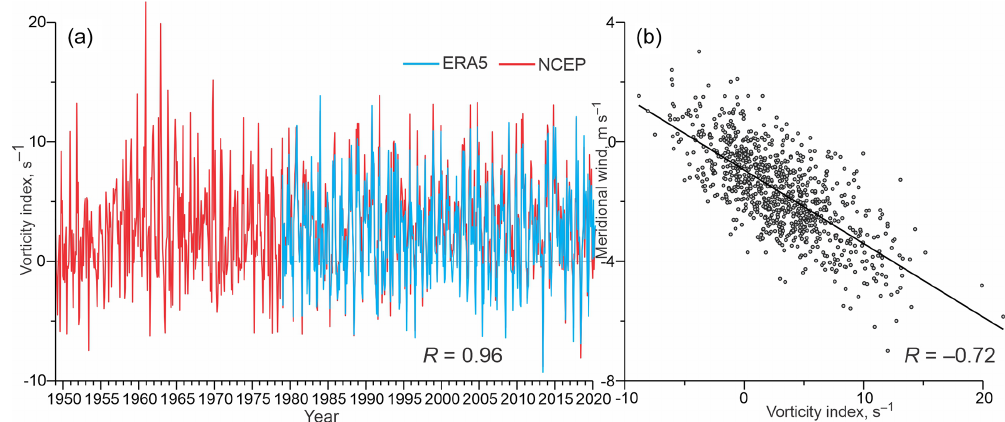
Figure 2. (a) Time series of the monthly mean atmospheric vorticity index (s − 1 ) over Hudson Bay, derived from NCEP (red) and ERA5 (blue). (b) Scatter plot of the monthly mean meridional wind seaward of Churchill in western Hudson Bay (ms − 1 ) versus the monthly mean atmospheric vorticity index. Thick black line depicts linear regression. Numbers at the bottom show correlation R between (a) the monthly mean vorticity derived from NCEP (1949–2000) and ERA5 (1979–2000) and (b) the monthly mean NCEP vorticity versus meridional wind